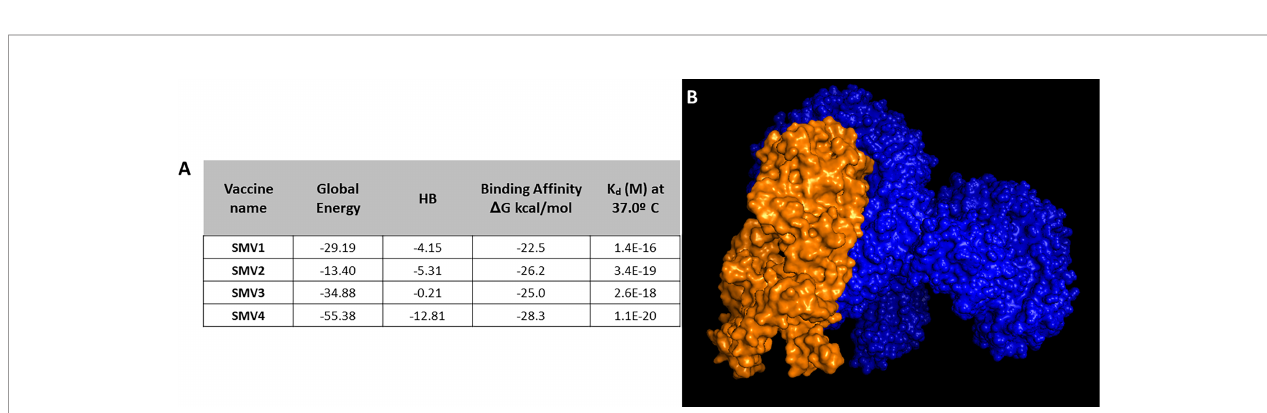
FIGURE 5 | (A) Docking analysis of vaccine constructs. (B) 3D representation of SMV4 vaccine construct and TLR4-MD2 complex. The SMV4 vaccine construct is represented by orange color, and TLR4-MD2 complex is in blue. The docking was carried out by ClusPro 2.0 and PatchDock servers, and re fi ned and re-scored by the PRODIGY tool of HADDOCK server, and FireDock server,